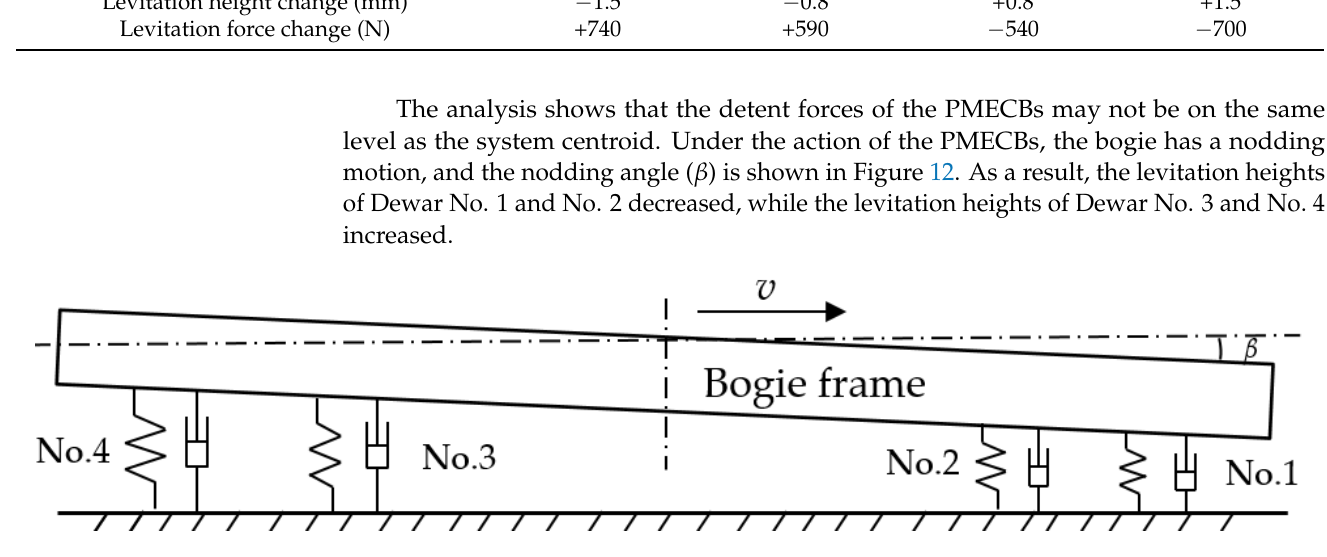
Figure 12. Schematic of the nodding motion of the HTS maglev test vehicle.